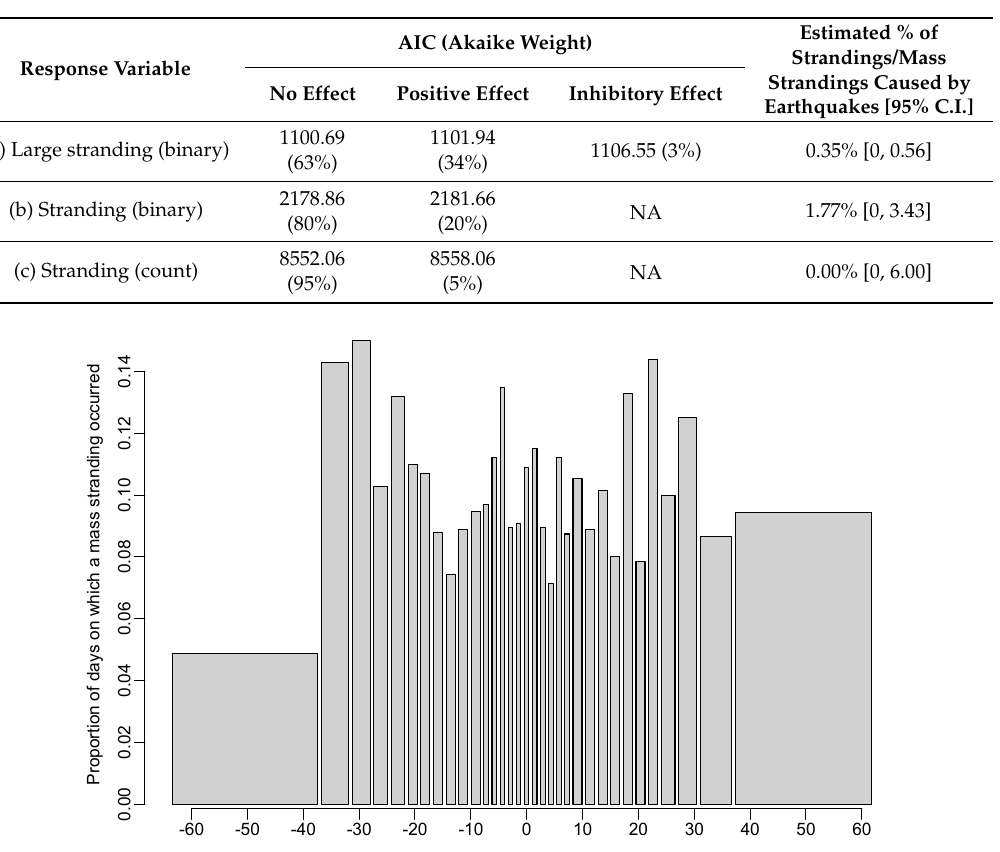
Figure 4. Bar plot of the proportion of days on which a mass stranding was recorded as a function of the number of days until the next earthquake (negative numbers) and the number of days since the previous earthquake (positive numbers). Categories are chosen such that there are at least 100 days in each.